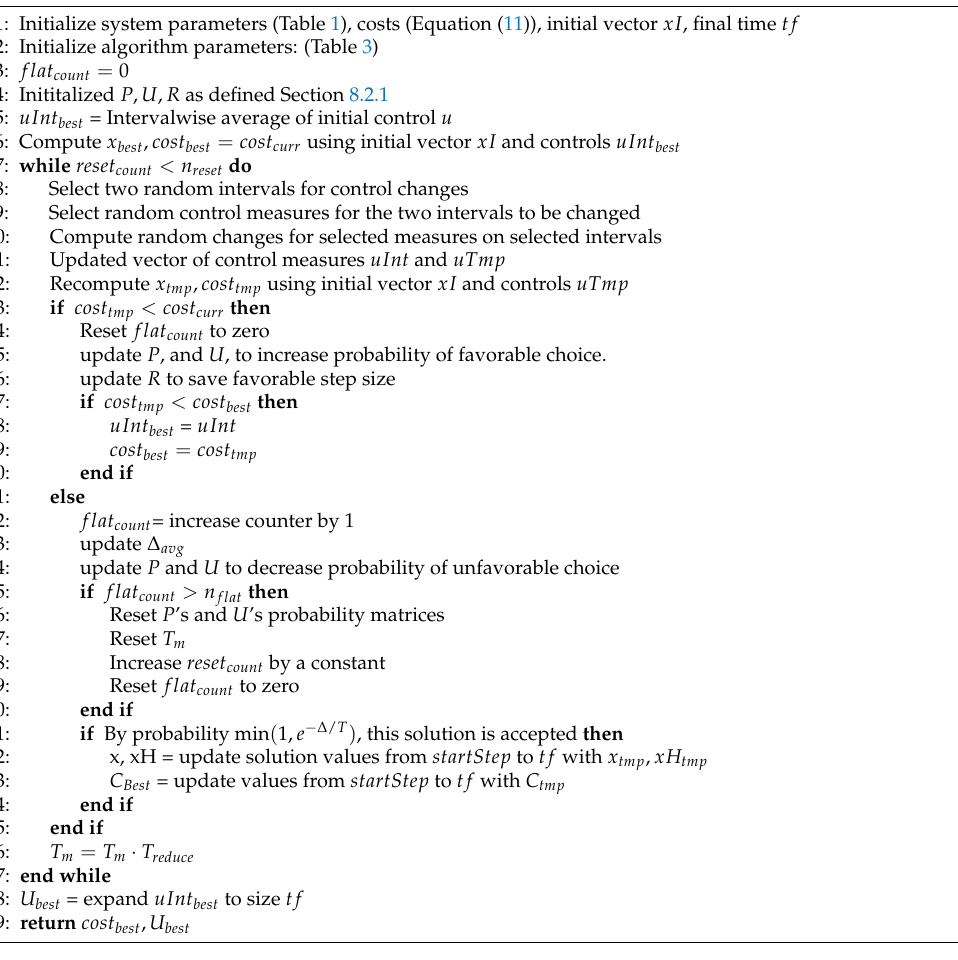
Algorithm 1: Monte Carlo algorithm